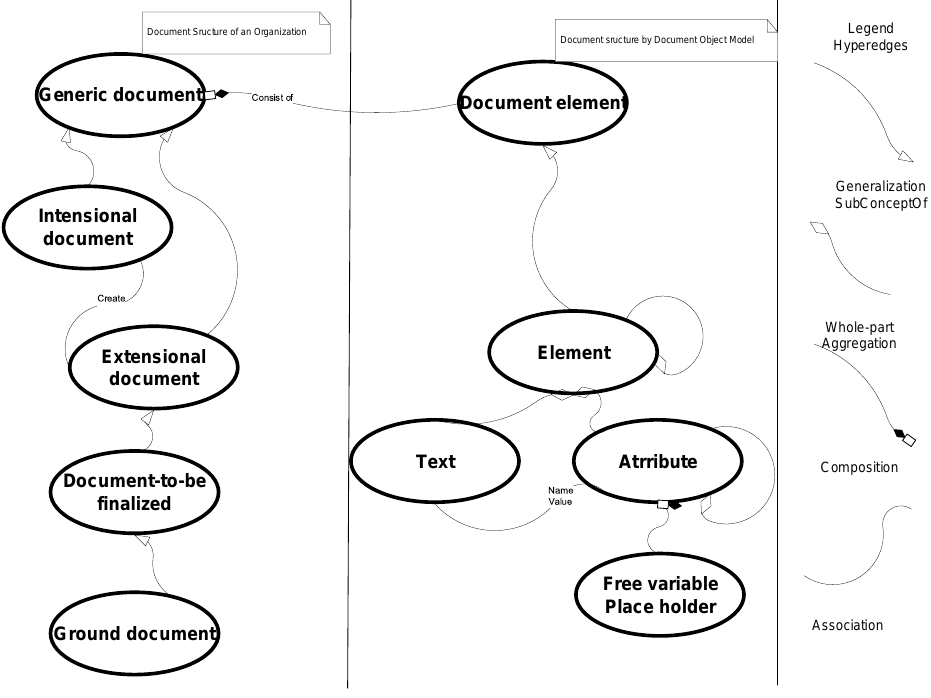
Figure 15. Hyper-graph model of